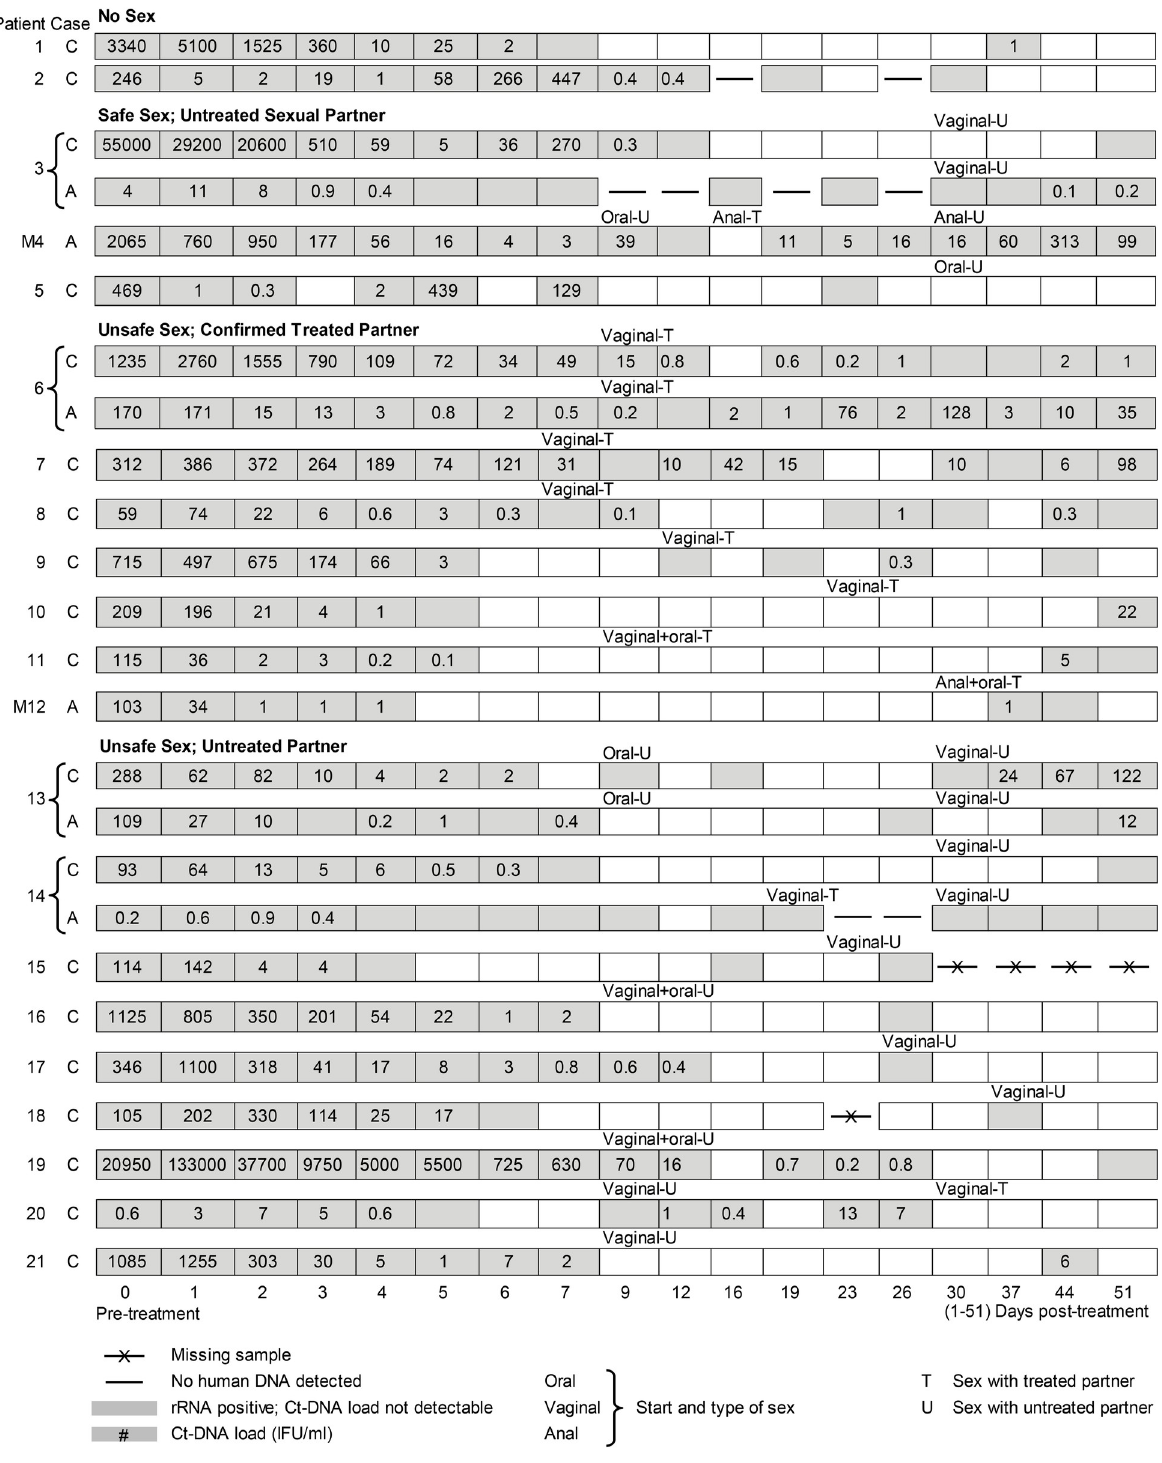
Fig 2. Multiple time-sequential measures (t = 18) of rRNA, DNA and quantitative load in Chlamydia trachomatis cases. Chlamydia trachomatis positivity and load among cases of cervicovaginal (C) and anorectal (A) infections in female and male (M) patients by sexual behavior. This Figure is reused content originally published by Dukers-Muijrers et al [2]. doi:10.1371/journal.pone.0081236.g003.